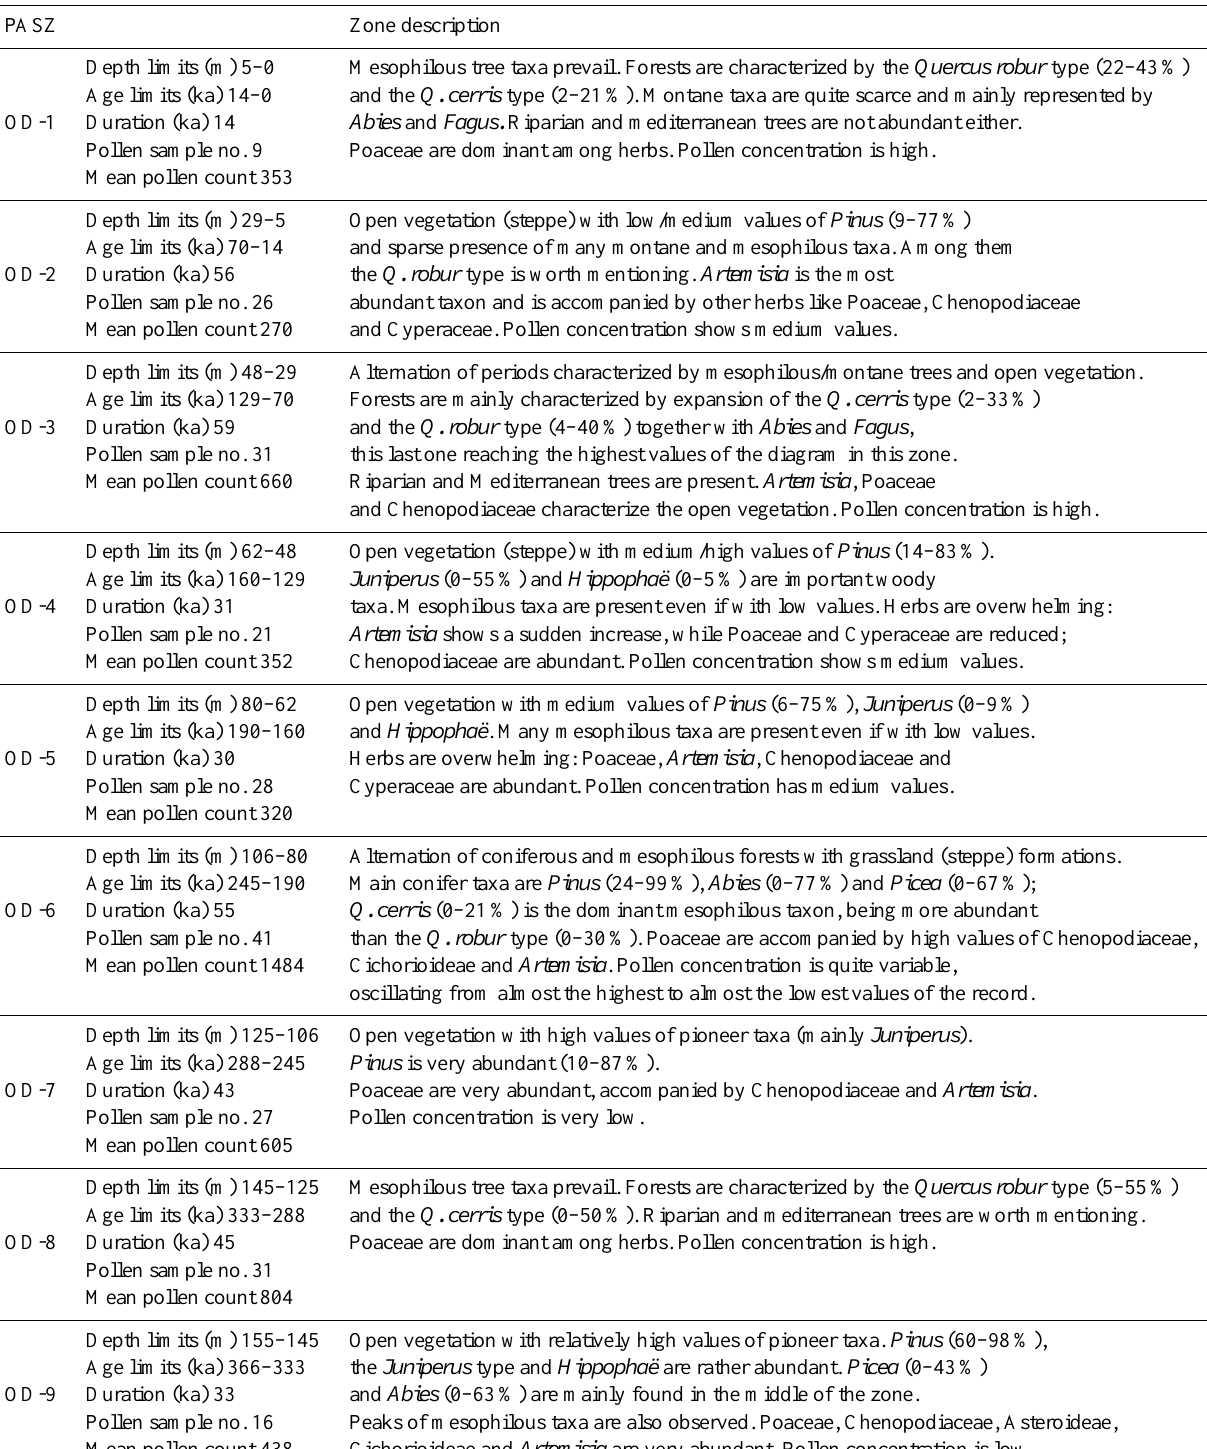
Table 1. Main vegetational features of Lake Ohrid DEEP core pollen assemblage zones (OD-PASZ) and related chronological limits. The basis sum for AP and NAP taxa does not include Pinus (see